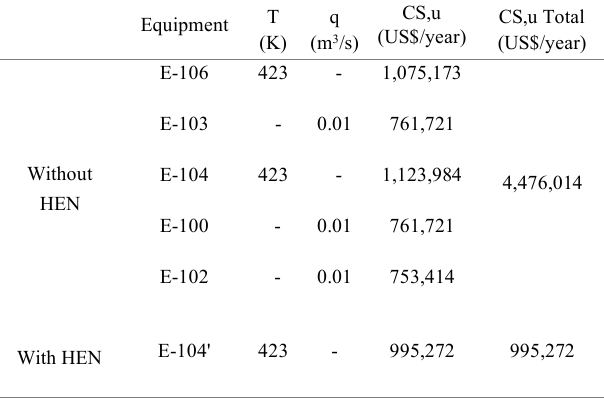
Table 5. External utility costs in the process with and without